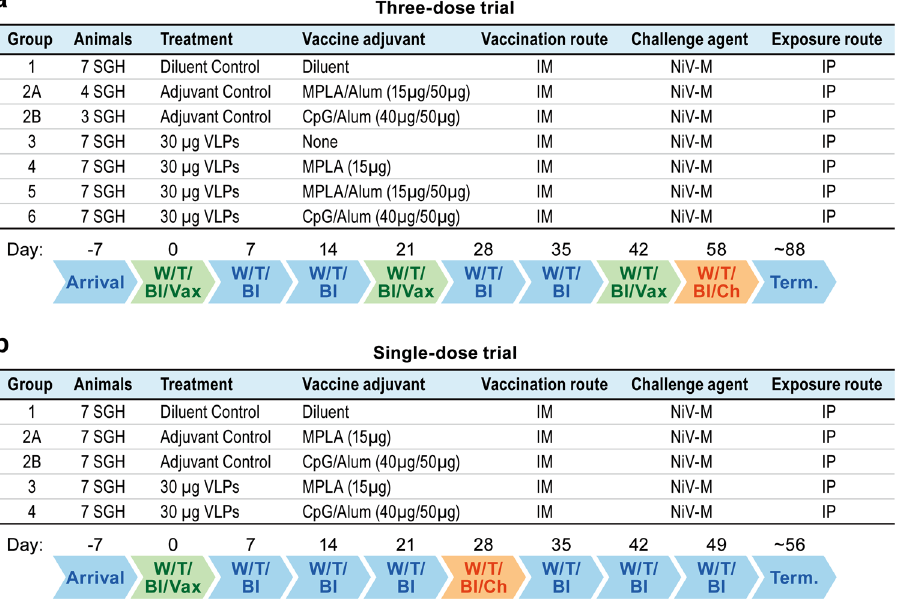
Fig. 1 Study schedule for the two vaccine trials. Charts indicate the schedule for the a three-dose vaccine trial and b single-dose vaccine trial. Indicated are the activities on various days relative to vaccination. W Weight; T Temperature; Bl Bleed; Vax Vaccination; Ch Challenge;